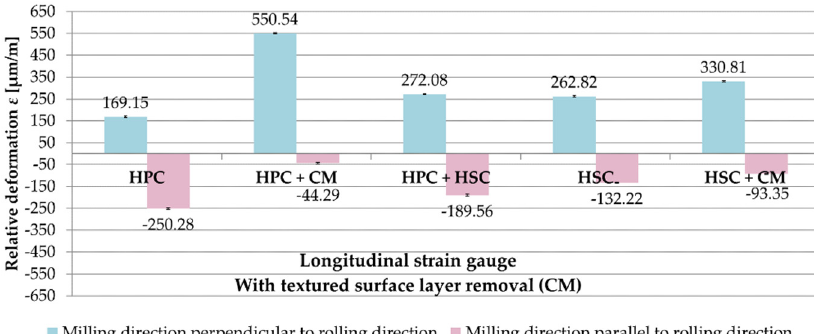
Figure 9. Comparison of relative deformations ε obtained on longitudinal strain gauges, depending on the relation of the milling direction to the rolling direction (samples with the removed surface layer—CM).